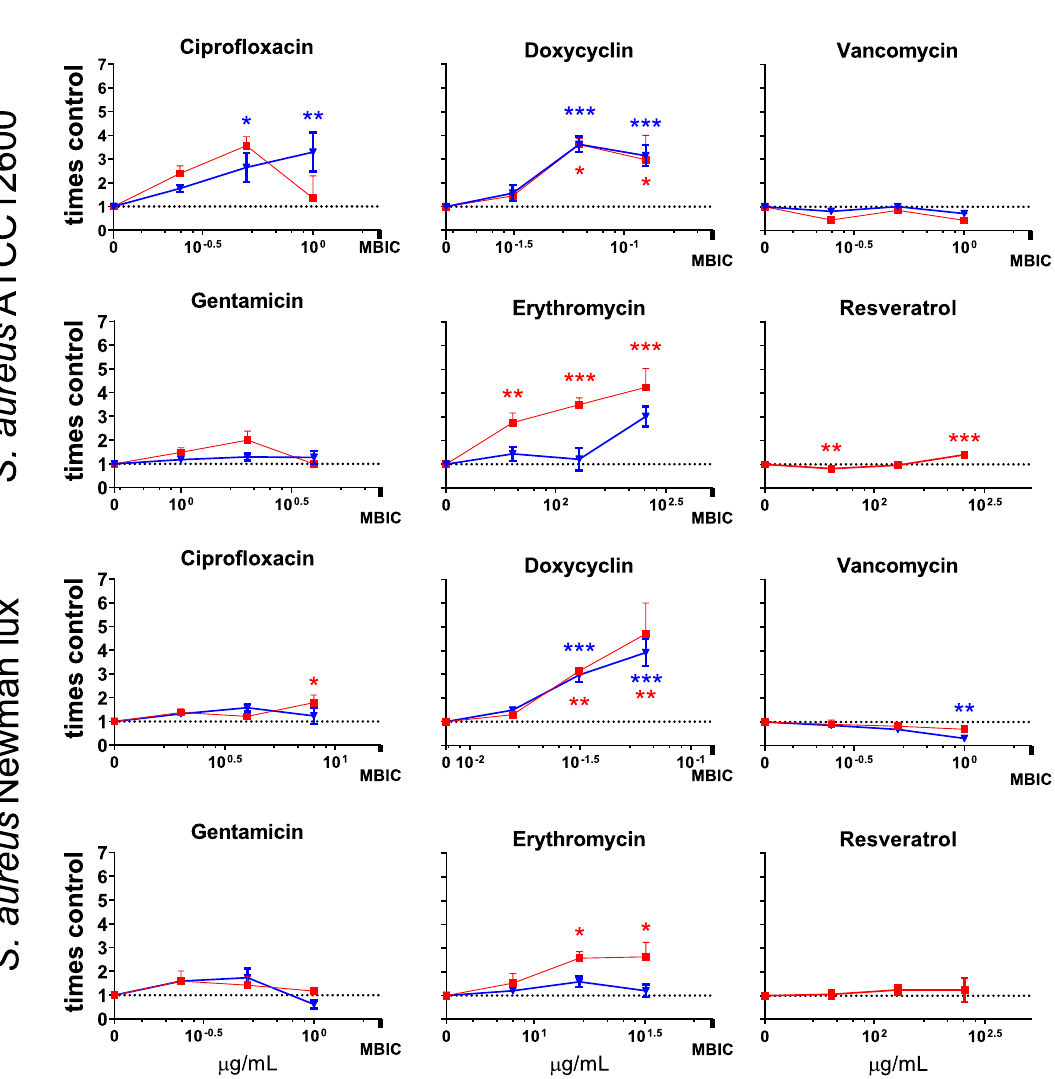
Figure 3. Change in biomass per CFU and polysaccharides per CFU ratios of S. aureus ATCC12600 and Newman lux biofilms. Biomass is quantified by crystal violet staining and subsequent measurement of spectral absorption at 590 nm. Polysaccharides are quantified by calcofluor white and subsequent measurement of fluorescent intensity at 355/490 nm (Ex/Em). Values shown is increase relative to the control biofilms without antibiotics (= 1; dotted horizontal line). Data shown are based on averages of triplicate measurements, repeated on separate days. Error bars indicate standard error of the mean. Statistical differences were calculated using an ANOVA comparing lognormal values (see “Materials and methods”). *Significant difference when compared to the culture without antibiotics (*p < 0.05; **p < 0.01; ***p < (Fig. 3), whereas gentamicin, vancomycin and resveratrol had a moderate to no effect. This is due to the biomass and polysaccharide content staying largely unchanged while the number of CFU’s decreased (Figs. 2 and S2). Effects of antimicrobials on nuclease activity per bacterium. CFU-counts in both biofilm and planktonic cultures (Fig. S2) were used to calculate the effect of antimicrobials on MN activity per viable bac- terium. In contrast to the stimulating effect of some antimicrobials on biomass and polysaccharides, MN activ- ity per CFU was unaffected or inhibited by antimicrobials (Fig. 4). Lognormal values of MN/CFU were used because this variable was lognormally distributed (see Fig. S3). In particular resveratrol inhibited MN per CFU 1 (cid:31) 8 MIC and MBIC, except for S. aureus ATCC12600 biofilms in which significantly at concentrations as low as 1 1 1 (cid:31) 8 and (cid:31) 4 , but not at (cid:31) 2 MBIC. Erythromycin reduced MN activity of the New- MN per CFU was inhibited at 1 (cid:31) 4 MBIC. man strain by almost 75% at